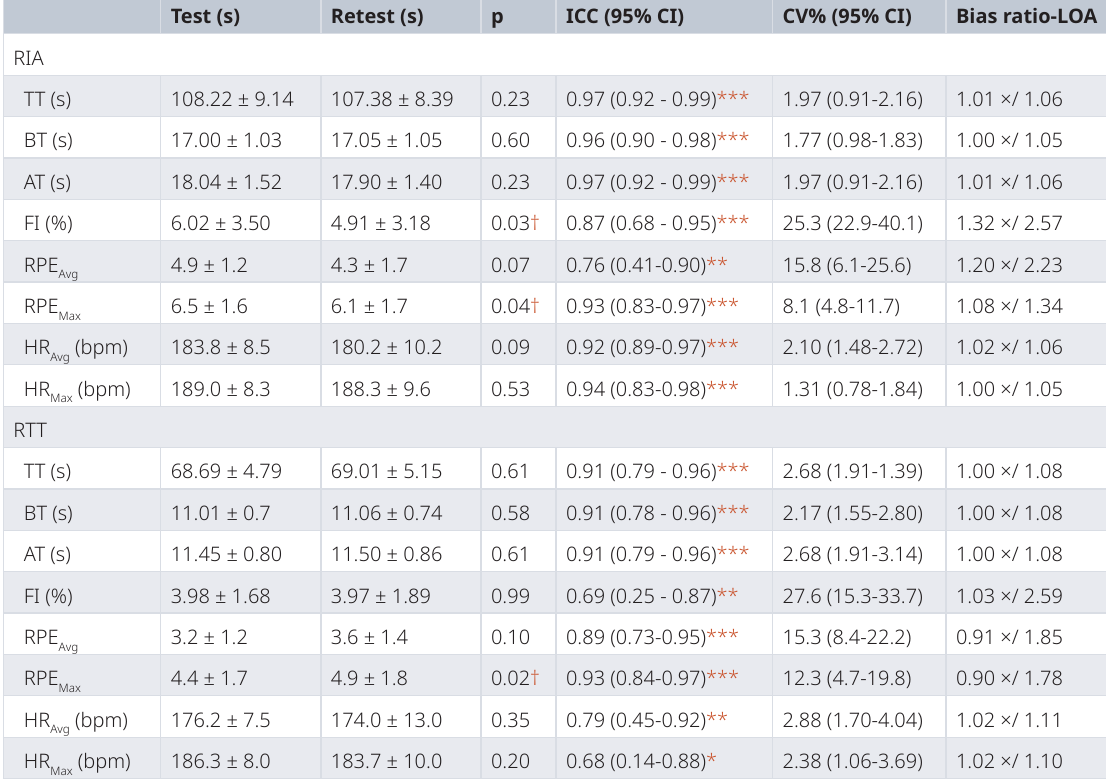
Table 3. Test-retest results, intra-class correlation coefficients (ICC, 95% confidence interval (CI)), measurement bias/ratio (log-transformed data) (×/÷ 95% ratio limits of agreement (ratio-LOA)) and within-subject coefficient of variation (95 % CI) of the repeated Illinois Agility (RIA) and T-test (RTT)